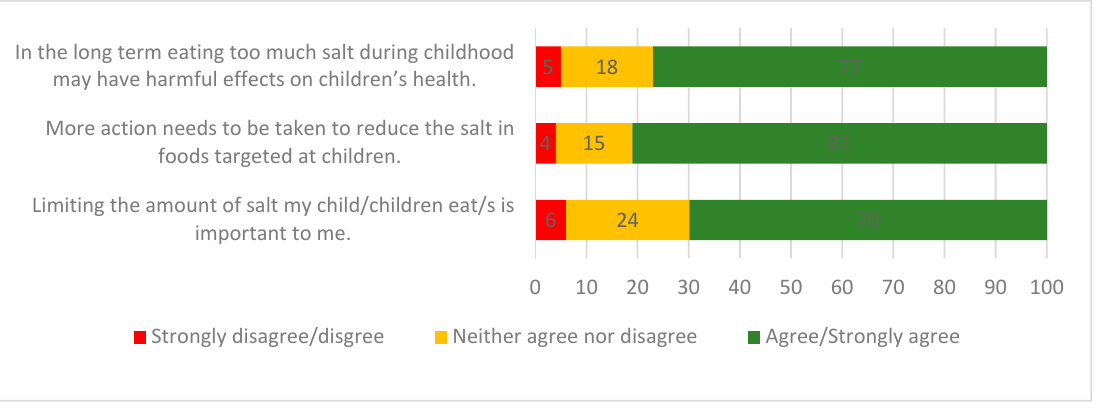
Figure 1. Parents’ knowledge and attitudes towards salt intake related to their child/children ( n = 837).